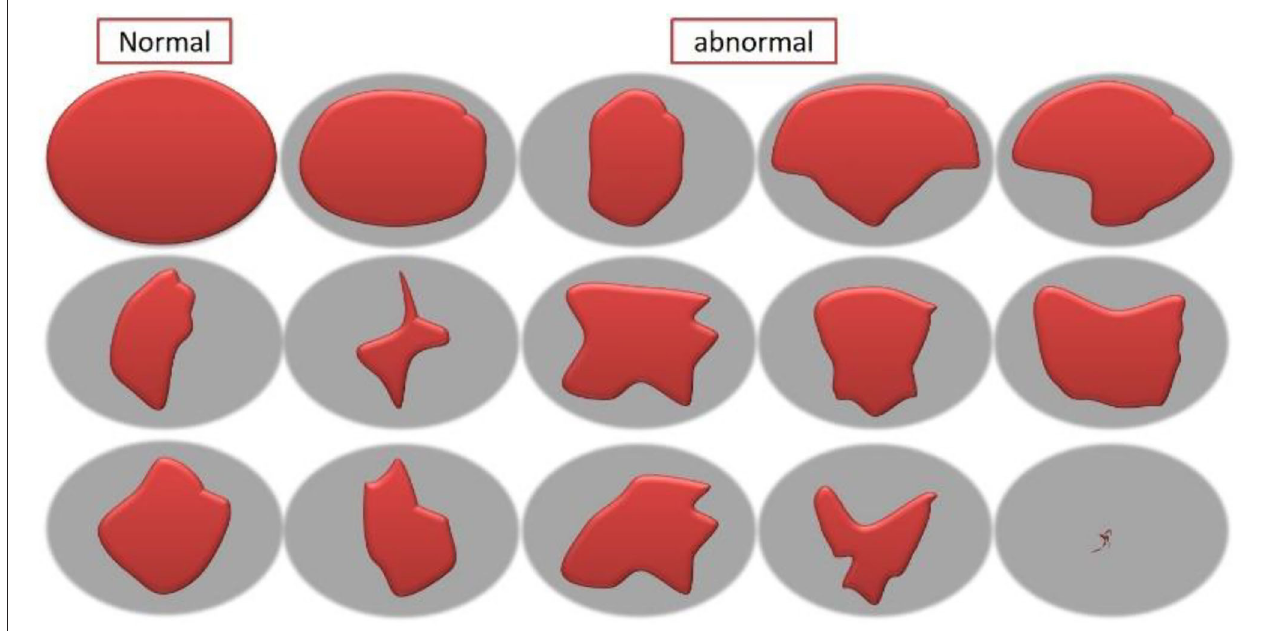
FIGURE 1 | Stylized forms of pollen grain shape aberrations observed in rice affected by Zn